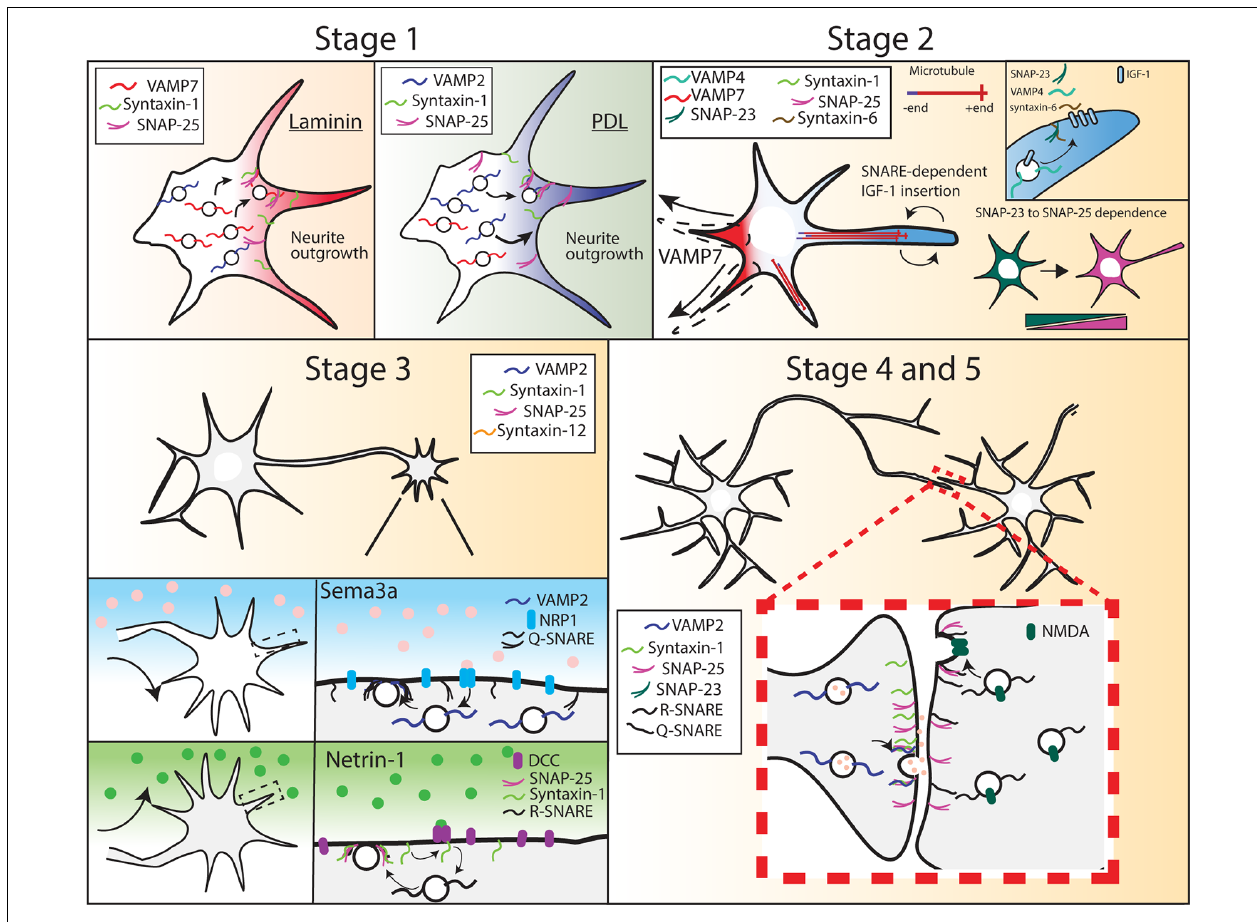
FIGURE 1 | Soluble N-ethylmaleimide-sensitive factor attachment proteins receptors (SNARE) expression and function during different stages of neuron development. Stage 1, R-SNARE usage is context-dependent, as cortical neurons grown on laminin require VAMP7 for neurite outgrowth, whereas neurons grown on PDL require VAMP2. Stage 2, a multitude of SNAREs are required for neurite outgrowth and axon specification. Neurite outgrowth becomes VAMP7-dependent, and soluble NSF-attachment proteins (SNAP-25) expression increases while SNAP-23 expression decreases. Stage 3, VAMP2, SNAP-25, and syntaxin-1 are required for axon attraction and repulsion in response to chemotrophic factors. Stage 4 and 5, VAMP2, syntaxin-1, and SNAP-25 are required at the pre-synapse for synaptic transmission. SNAP-25 is required at the post-synapse for SNARE-mediated NMDA receptor